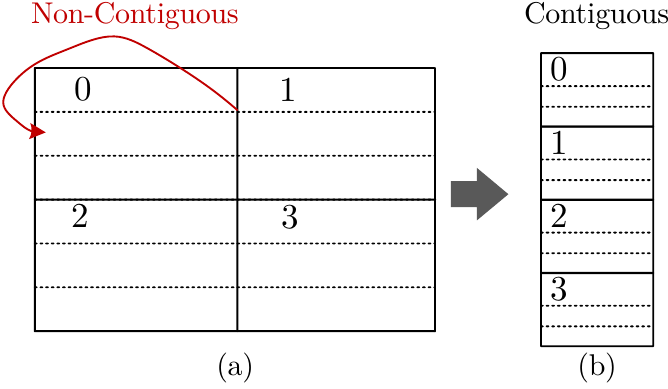
Figure 15. Partitioned memory to ensure contiguous access. ( a ) Non-Contiguous ( b )